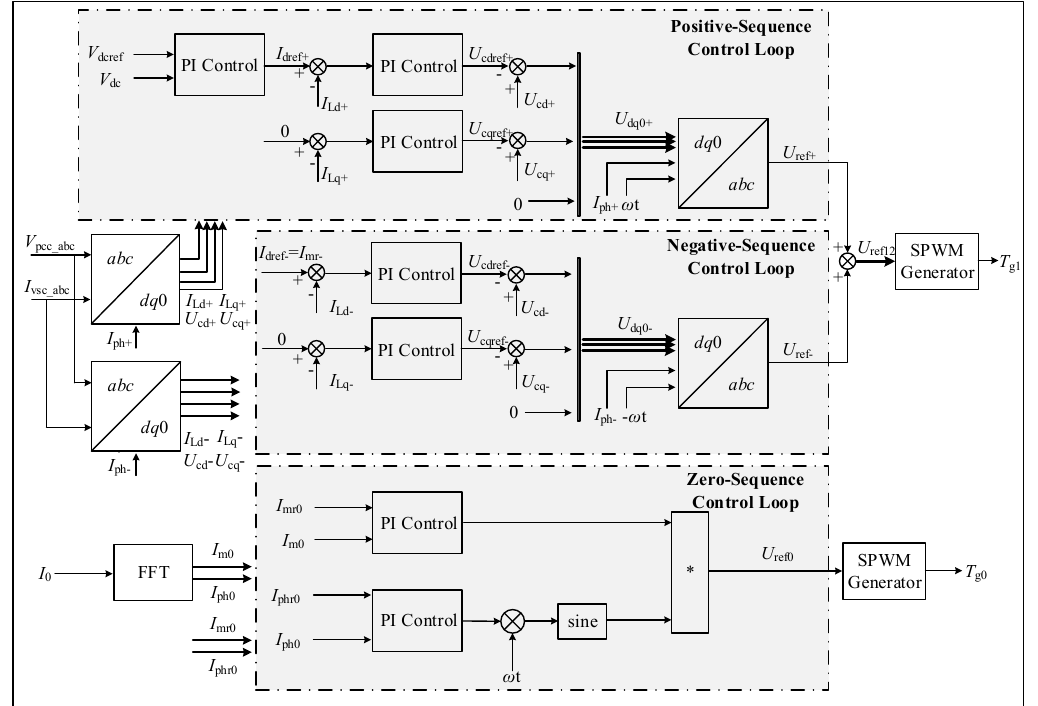
Figure 6. The control scheme of the proposed imbalance mitigation method based on the AAEA Unit.